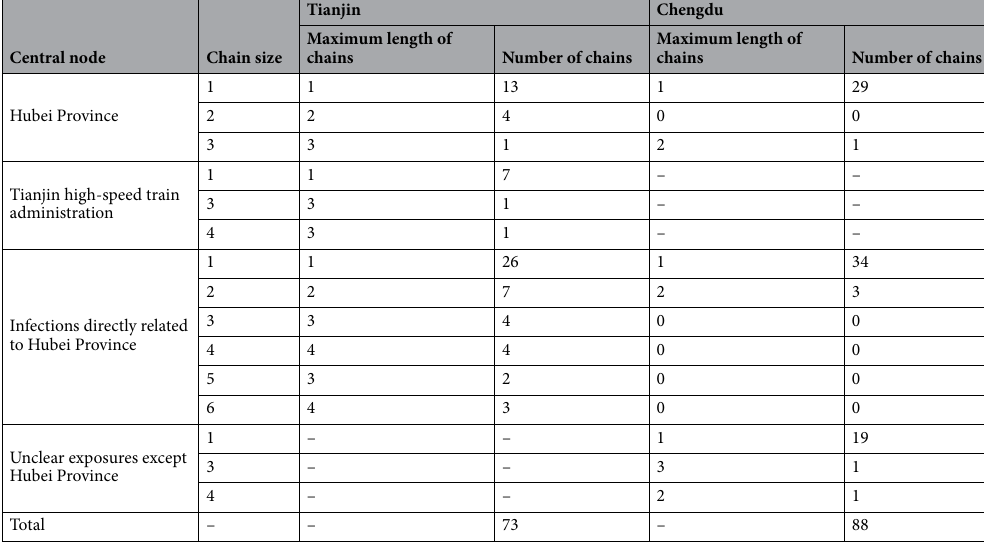
Table 2. Distribution of transmission chains for COVID-19 cases in Tianjin and